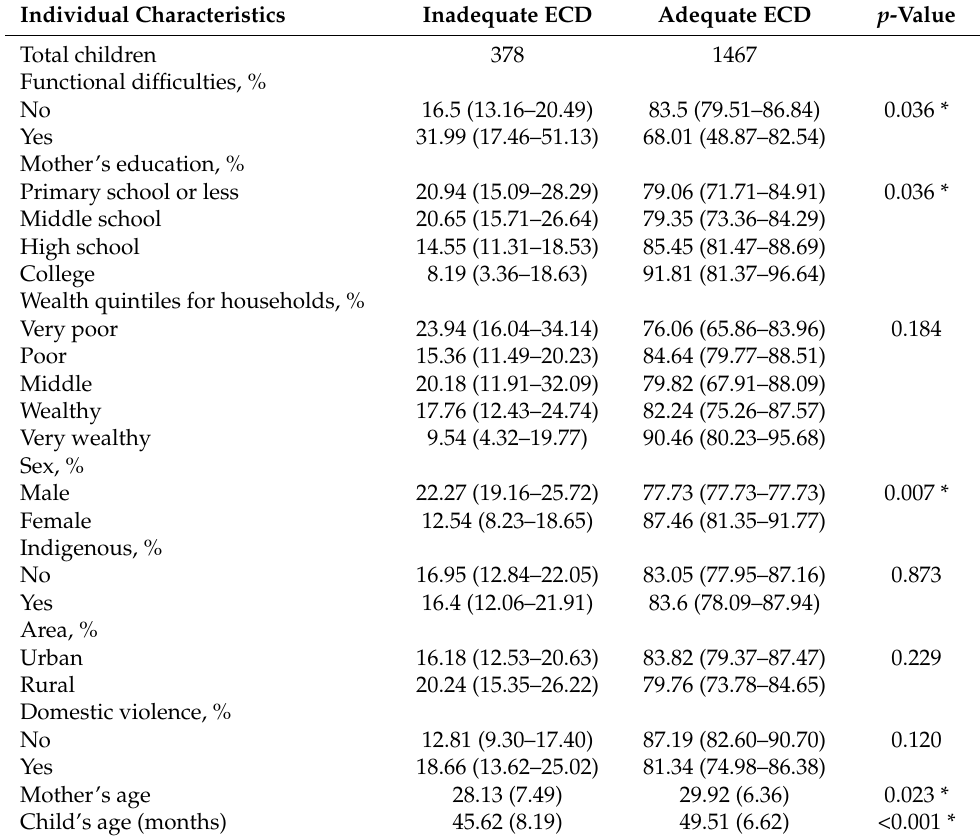
Table 1. Individual Characteristics of Children with Inadequate and Adequate Early Childhood Development.